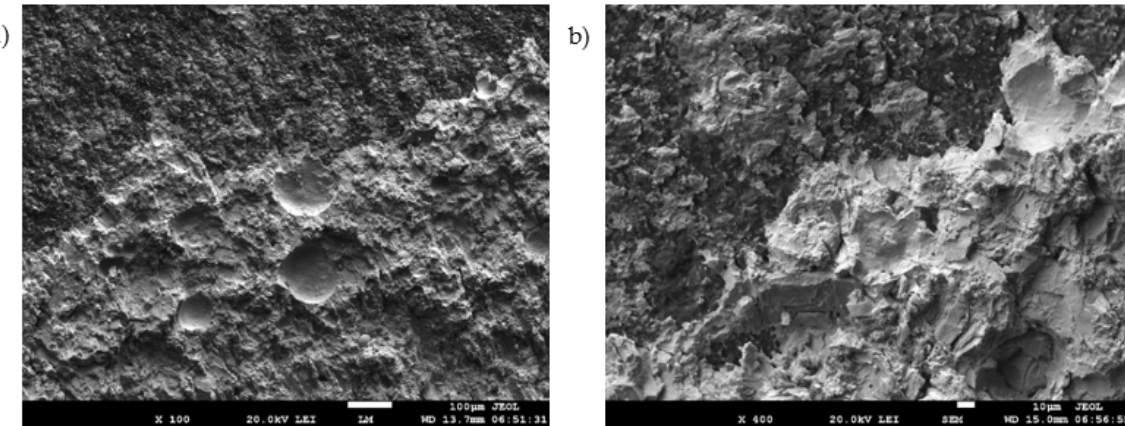
Figure 23. Fractured surface of soldered joint of Si/BiAg11Ti1,5/Cu ( a ) magnification 100 × ; ( b ) magnification 400 × .